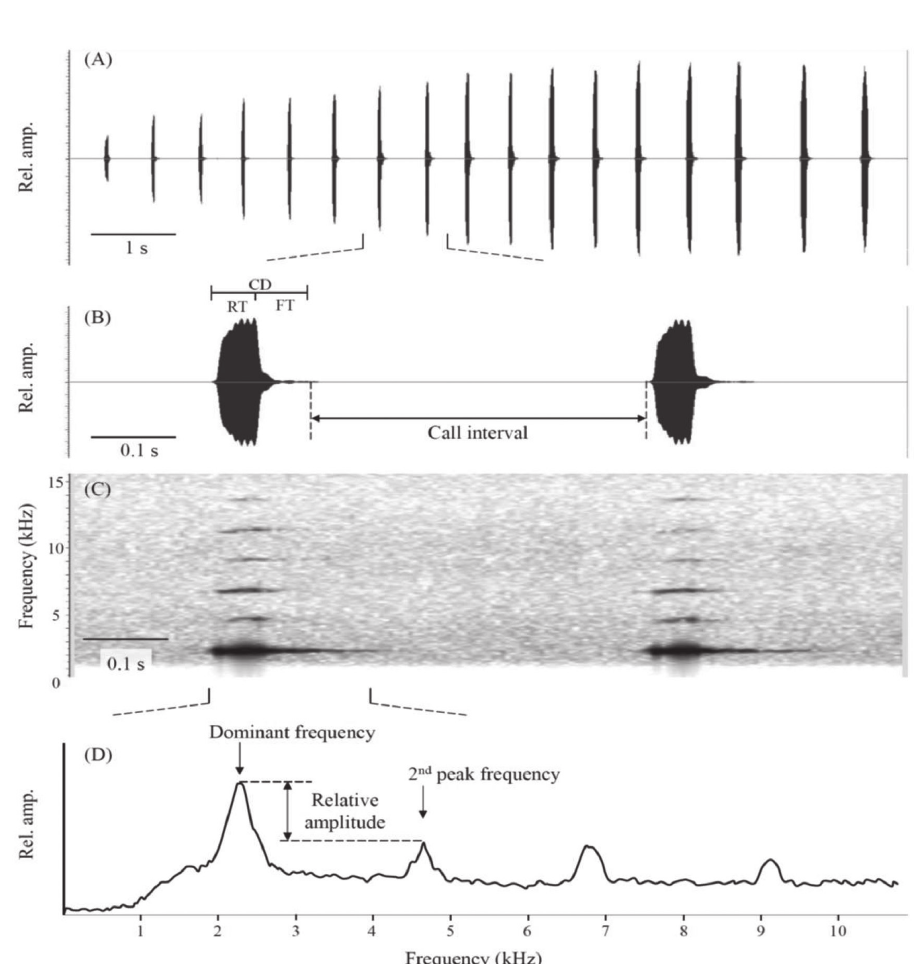
Figure 3. The call property measurements. This figure shows A the waveform of entire series of a con- secutive call B the waveform C the spectrogram of two calls and D the spectral power distribution of a single call from the new Kurixalus population from Zhejiang, China. We extracted the number of calls in a bout, call interval, call duration (CD), rise time (RT), fall time (FT), dominant frequency (here also the max frequency), secondary peak frequency and the relative amplitude of two nostril to eye ( DNE ), from the posterior border of nostril to anterior border of the eye, narrowest interorbital distance ( IOD ), greatest horizontal tympanum diameter ( TMP ), tympanum-eye distance ( TEY ) from anterior edge of tympanum to posterior corner of eye, hand length ( HND ) from distal end of radio-ulna to tip of finger III, radio-ulna length ( RAD ), forelimb length ( FLL ), distance from the proximate end of radio-ulna to distal end of finger III, thigh length ( THL ), distance from vent to distal end of femur, tibia length ( TIB ), foot length ( FL ) from proximal end of inner